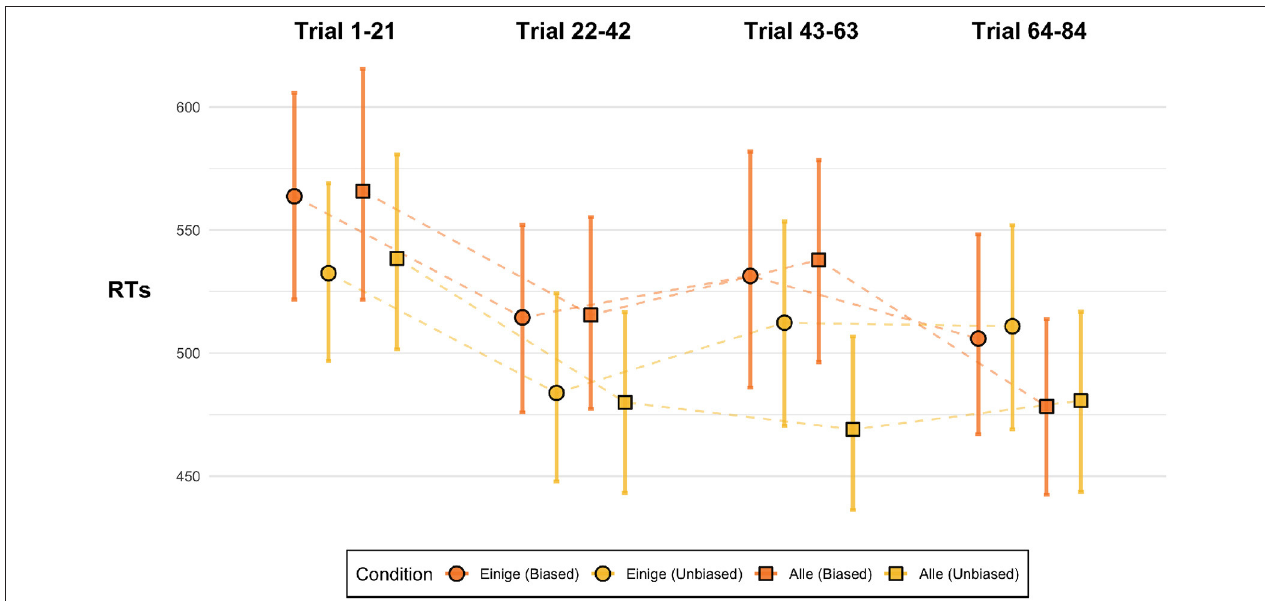
FIGURE 8 | Reading times at the SHAPE region for the critical conditions for different blocks of the experiment. The dots show means, error bars are 95% bootstrapped confidence